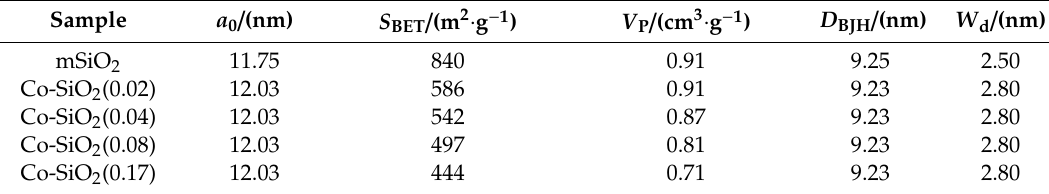
Figure 5. N 2 adsorption–desorption isotherms ( a ) and pore size distribution curves ( b ) of the mesoporous Co–SiO 2 ( x ) catalysts. Table 1. N 2 physisorption results of the mesoporous Co–SiO 2 ( x )